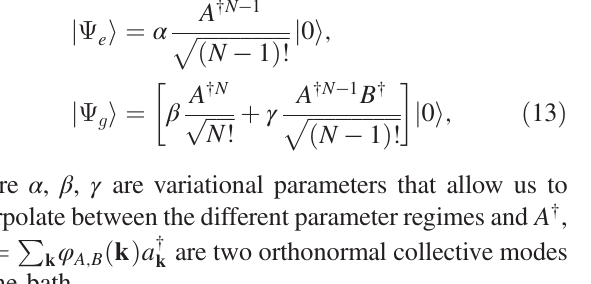
FIG. 3. Comparison of the bound state energies variational Ansätze (solid lines) with infinite bath size and the DMRG results (markers) in the (a) N ¼ 3 and (b) N ¼ 4 subspaces. The three different curves correspond to the three different paths depicted in Fig. 2, i.e., choosing a detuning Δ